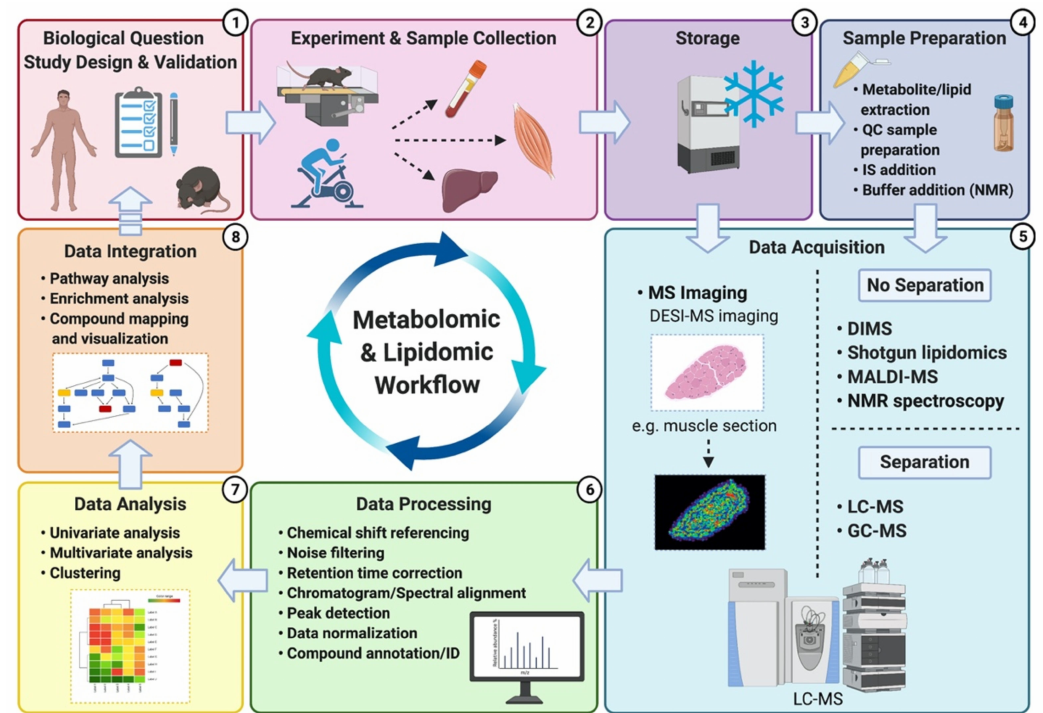
Figure 2. Typical metabolomics/lipidomics workflow: ( 1 ) After establishing a given biological question, appropriate and optimized study design is a critical step to answer this biological question with minimal bias and noise (i.e., investigation- induced variability). ( 2 ) Sample collection before/during/after the experiment also requires particular attention and care to avoid introducing potential biases. Therefore, consistency of collection timing, materials and reagents is important. Metabolic reactions are rapid and must be stopped as soon as possible following collection by snap freezing or placing the sample on ice. ( 3 ) Samples are then prepared accordingly (e.g., centrifugation of whole blood to collect plasma or serum) for storage until planned sample preparation or direct data acquisition. ( 4 ) Sample preparation depends on the analytical platforms utilized and the molecular species to be extracted (e.g., lipids or other metabolites). During this step, QC samples are usually prepared and IS added to all aliquots to screen and correct platform-related shifts and enhance reproducibility. ( 5 ) Samples are analyzed and data are acquired using one or multiple analytical platforms. ( 6 ) Acquired raw data are then processed through multiple steps to eventually allow accurate compound identification/annotation. ( 7 ) Multiple statistical tests are performed on the identified/annotated compounds to determine potential differences between samples and/or groups in line with the biological question and experimental design. ( 8 ) Finally, data are placed into